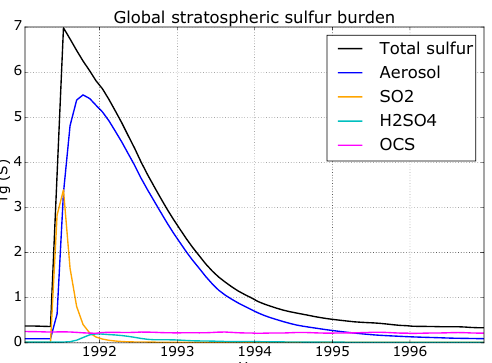
Figure 9. Evolution of the modelled stratospheric sulfur burden and its distribution among the different species for the period from Jan- uary 1991 to December 1996, including the Pinatubo eruption (but no other eruptions).